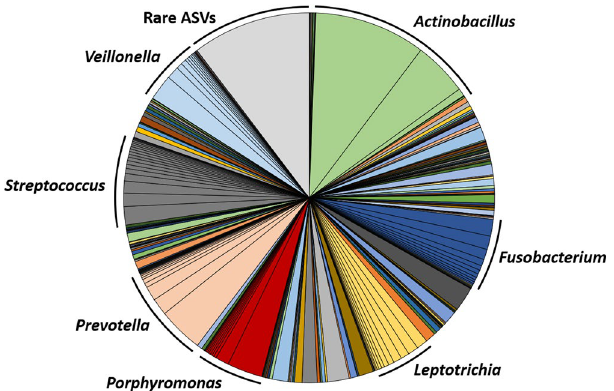
Figure 5. Pie chart showing the mean relative abundance of ASVs detected in the gingival swabs, with dominant genera labeled. The grey portion represents a total of 8544 rare ASVs, comprising roughly 10% of any given